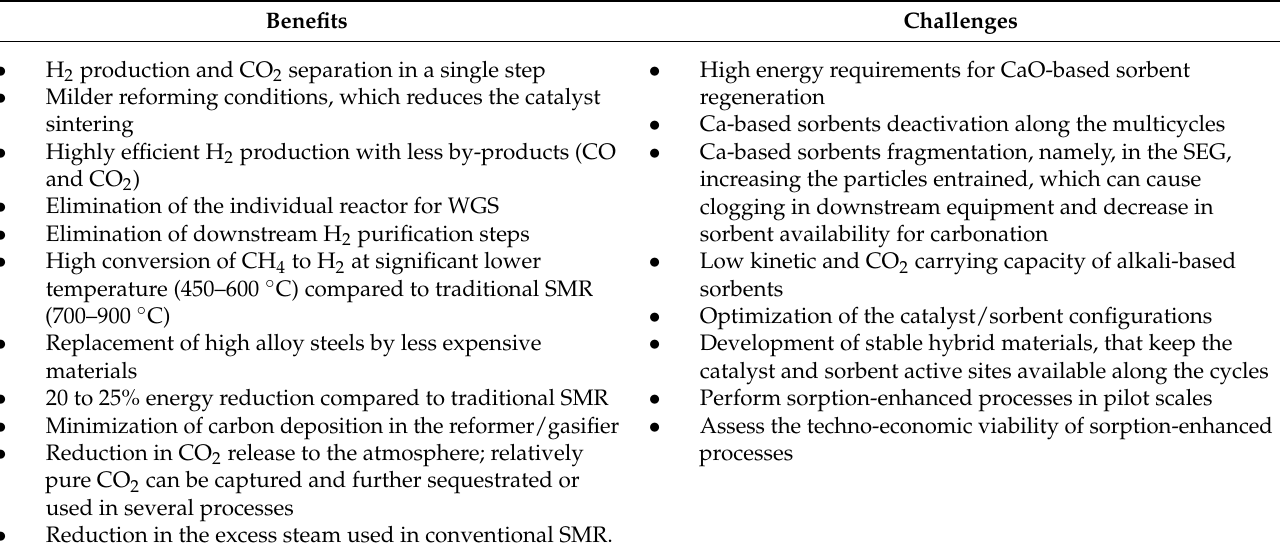
Table 8. Summary of benefits and challenges of sorption-enhanced steam reforming and